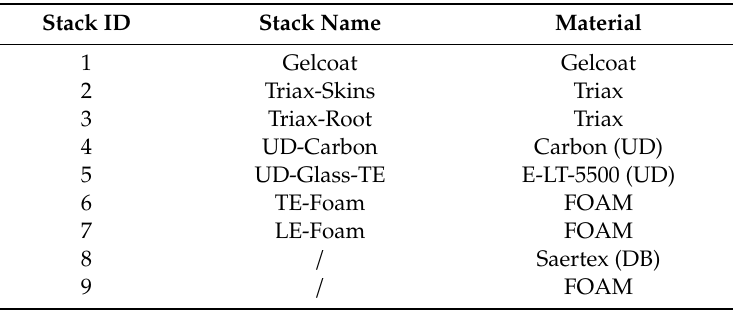
Table 4. Mapping of stacks and materials (created referring to [18]).